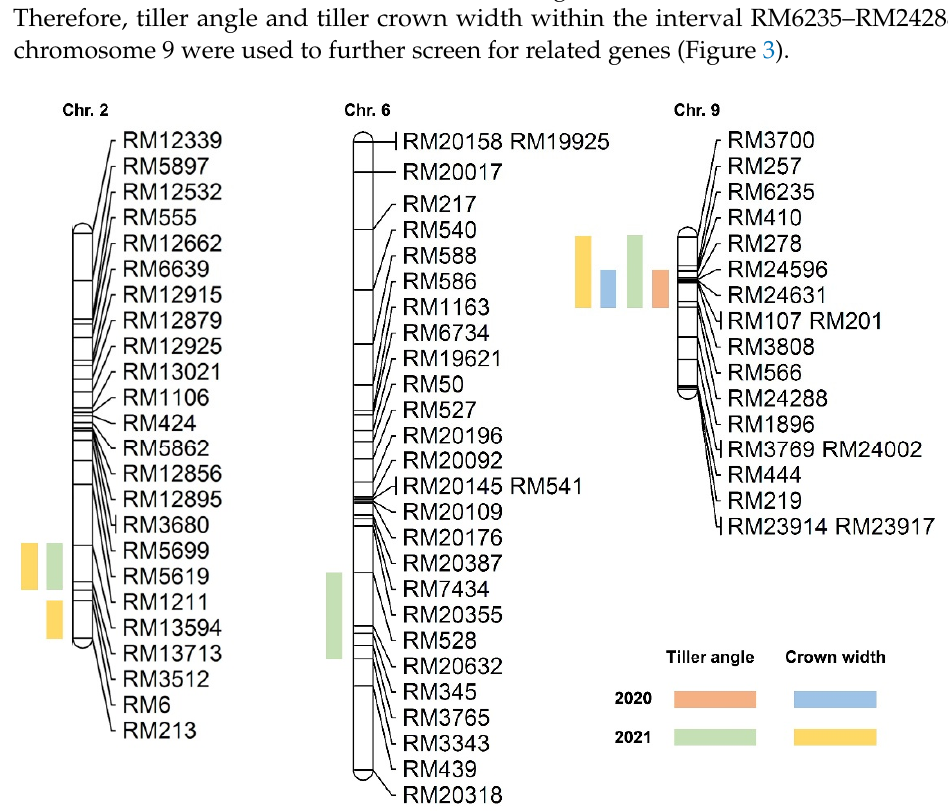
Figure 3. The location of QTL on chromosomes is associated with tiller angle and tiller crown width in the CNDH population. QTL analysis results show that tiller angle-related genes are located on chromosomes 2, 6, and 9. Among them, RM6235-RM24288 on chromosome 9 is a significant location that was detected over two years.